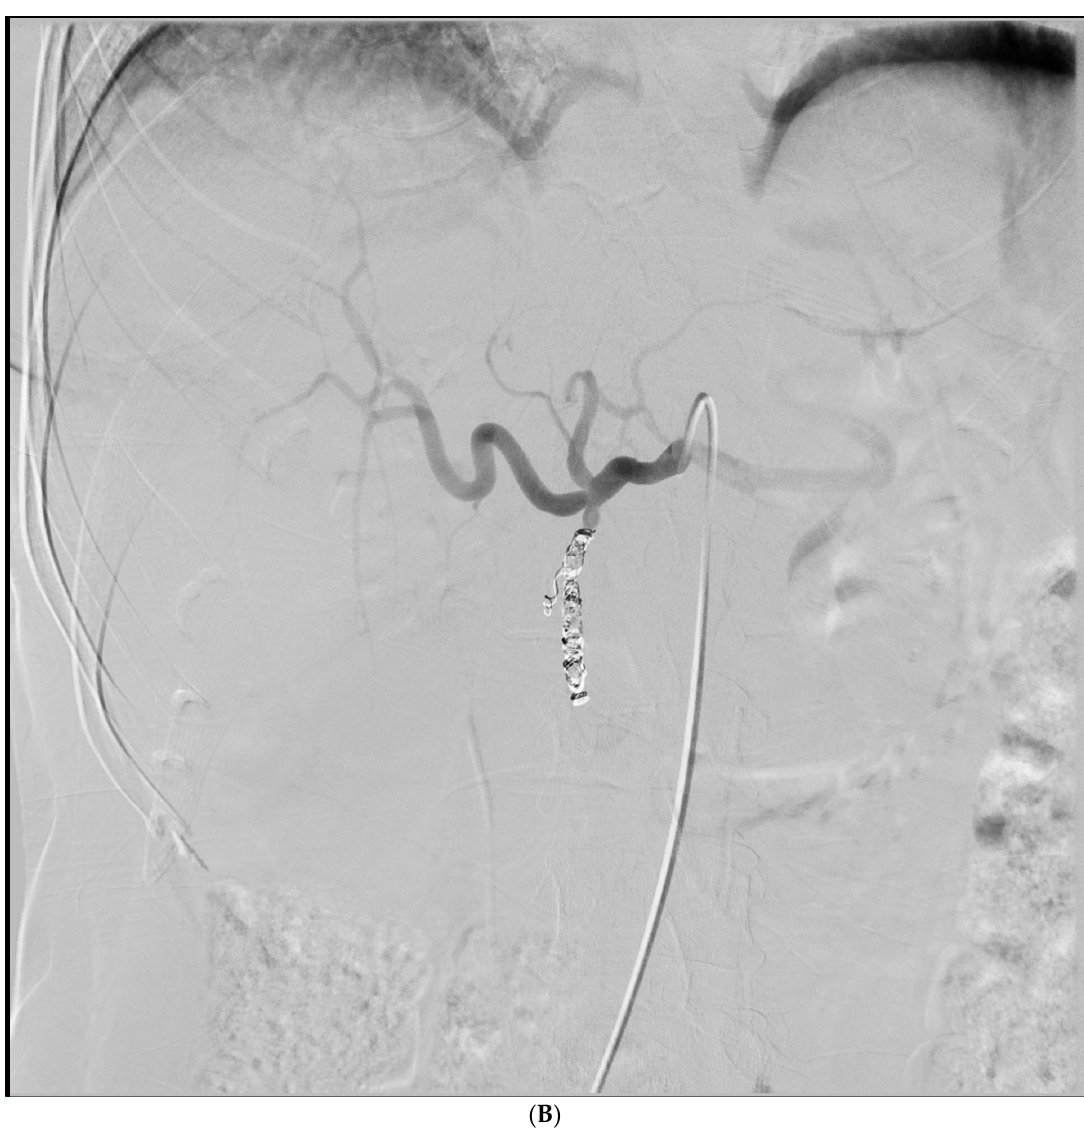
Figure 5. This 48 year old female with metastatic colo-rectal cancer was referred for selective internal radiation therapy, using Yittrium-90. The ( A ) mapping angiogram showed a trifurcation of the common hepatic artery into the GDA (dashed arrow), left hepatic (curved arrow), and right hepatic (straight arrow) arteries. GDA embolization with this anatomic configuration was felt to be necessary in order to reduce the chances of the non-target duodenal embolization. The ( B ) GDA was successfully cannulated with a microcatheter, and multiple coils were placed successfully, which embolized this vessel. The Yttrium-90 (Y-90) administration was subsequently performed without clinical or radiographic evidence of non-target embolization to the duodenum.